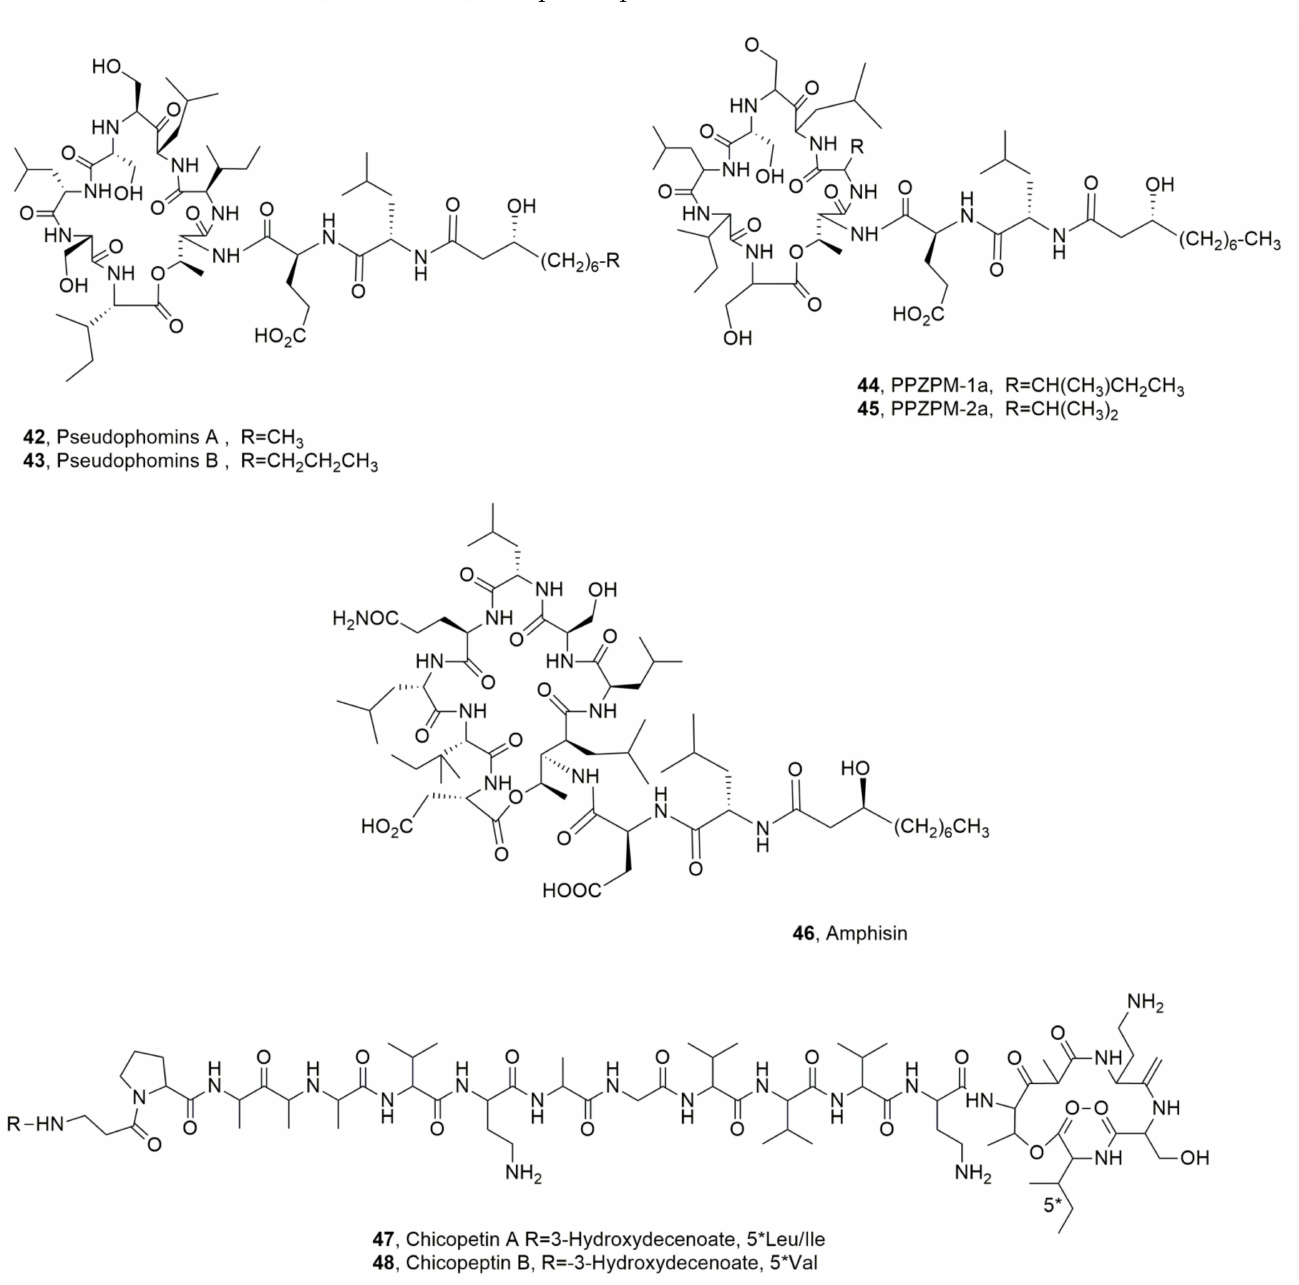
Figure 7. Structures of lipodepsipeptide produced by Pseudomonas fluorescens ( 42 and 43 ), Pseudomonas sp. JX090307 ( 44 and 45 ), Pseudomonas sp. ( 46 ), and Pseudomonas cichorii ( 47 and 48 ). PPZPM-1a and PPZPM-2a ( 44 and 45 , Figure 7) are the main LPDs among the mixture of more than 30 cyclodepsipetides produced by Pseudomonas sp. JX090307 , which was isolated from hyphae of the phytopathogenic oomycete Phytophthora alni spp. alni and appeared close to Pseudomonas orientalis . The cell extract of Pseudomonas sp.